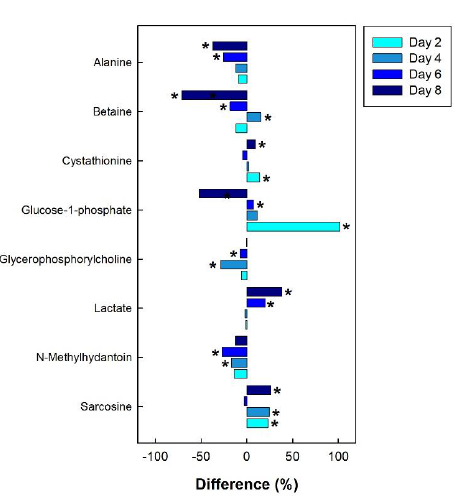
Figure 10. Regulation of common metabolites in the kidneys of broiler chicks subjected to stressors relative to the control treatment at the four experimental endpoints. ( A ) Corticosterone (blue); ( B ) heat (red); and ( C ) isolation (green). Metabolites that were altered ( p < 0.050) are indicated by asterisks. In the breast muscle of chicks administered corticosterone, the amino acid alanine was down-regulated, along with glycero-phosphorylcholoine and N-methylhydantoin, while lactate and sarcosine were up-regulated (Figure 11). In the hippocampus of birds administered corticosterone, tyrosine and glutamate were down-regulated, and creatine was up-regulated (Figure 12A). For the heat treatment, anserine was initially up-regulated in the hippocampus of chicks after 2 days of heat treatment, and relative concentrations dropped over time thereafter (Figure 12B). In chicks subjected to isolation stress, glutathione was significantly up-regulated in the hippocampus after 4 and 8 days of isolation stress (Figure 12C).